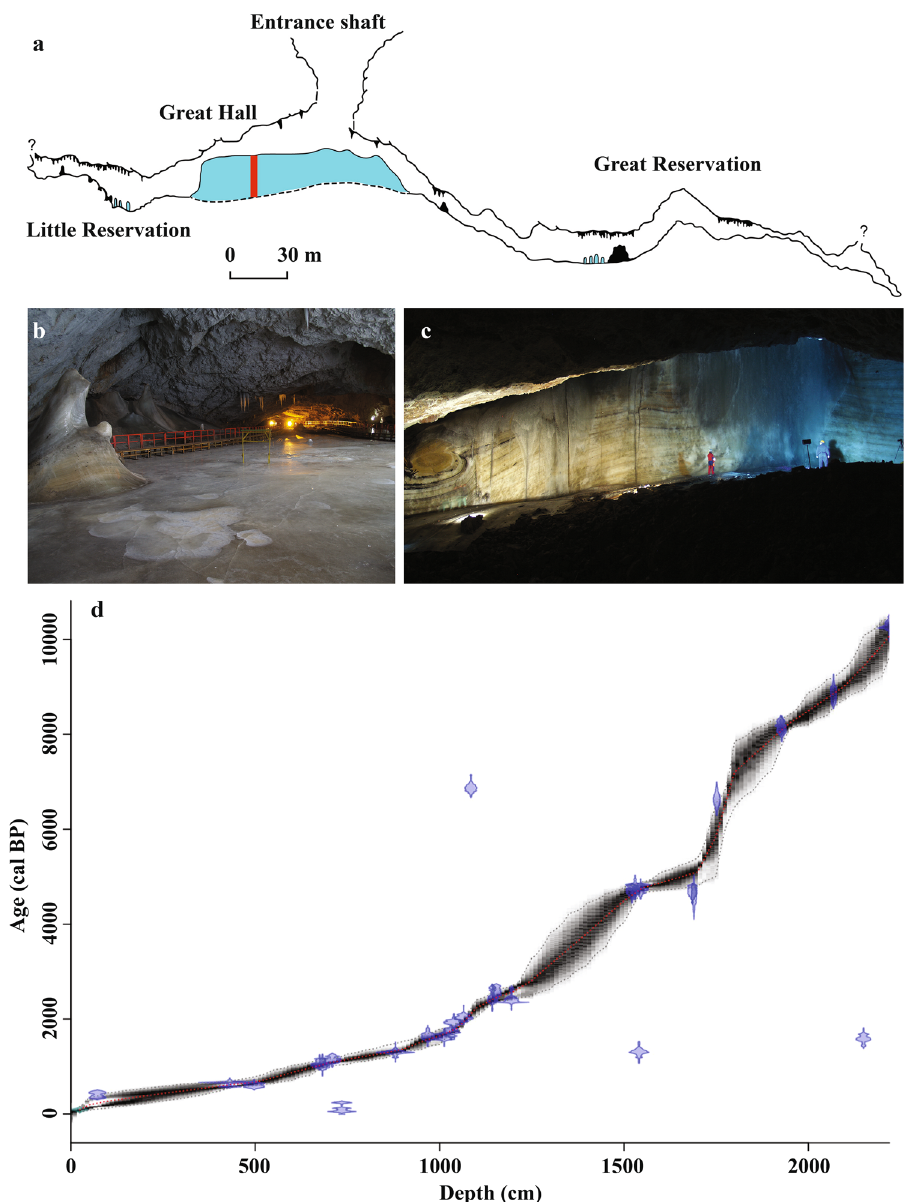
Figure 2. Scărișoara Ice Cave. ( a ) Cross-section of the cave. Red bar marks the position of the drilling site. ( b ) Surface of the ice block. ( c ) Side view of the ice block with visible layering. ( d ) Age-depth model of the ice block. The map in ( a ) is from the archives of the Emil Racoviță Institute of Speleology. The digital version was produced using Adobe Illustrator CS6 (http://www.adobe.com/products/illustrator.html). Photos in ( b ) and ( c ) by Aurel